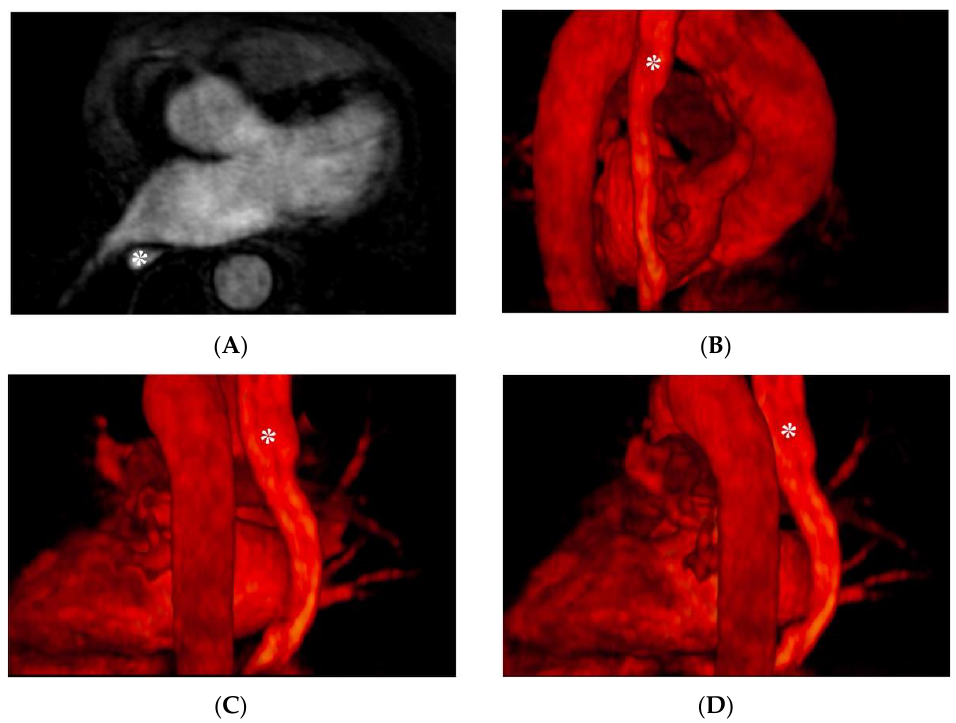
Figure 3. CMR images depicting the anatomical relationship between the esophagus (indicated with the asterisk): Panel ( A ): axial plane, angiographic CMR acquisition; panel ( B – D ) 3D volume rendering. Table 1. Most used cardiac magnetic resonance sequences for atrial